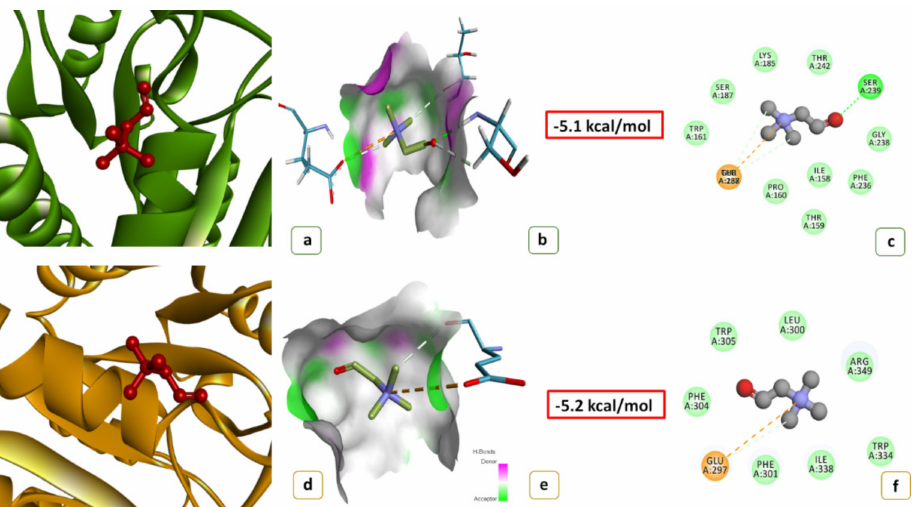
Figure 3. Docking analysis of PaBADH2 with betaine aldehyde (BAD): ( a ) docked 3D structure of PaBADH2-BAD complex; ( b ) showing H-bond donor (pink) and acceptor (green) surfaces in PaBADH2-BAD complex; ( c ) the 2D view of interacting residues of PaBADH2-BAD complex at ligand binding site that involves H-bond (green circle), Van der Waals bond (light green circle) and electro- static interaction (brown circle); ( d ) docked 3D structure of OsBADH2-BAD complex; ( e ) showing H-bond donor (pink) and acceptor (green) surfaces in OsBADH2-BAD complex; ( f ) the 2D view of interacting residues of OsBADH2-BAD complex at ligand binding site that involves H-bonds (green circle), Van der Waals bonds (light green circle), and electrostatic interaction (brown circle).